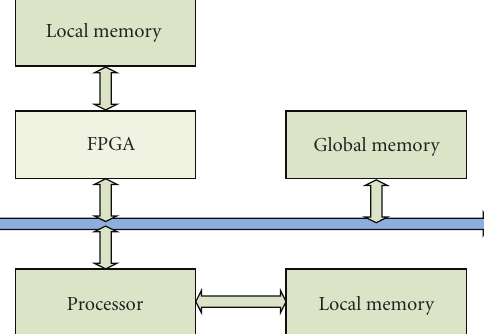
Figure 4: Architecture model for HW/SW Codesigned reconfig- urable devices.